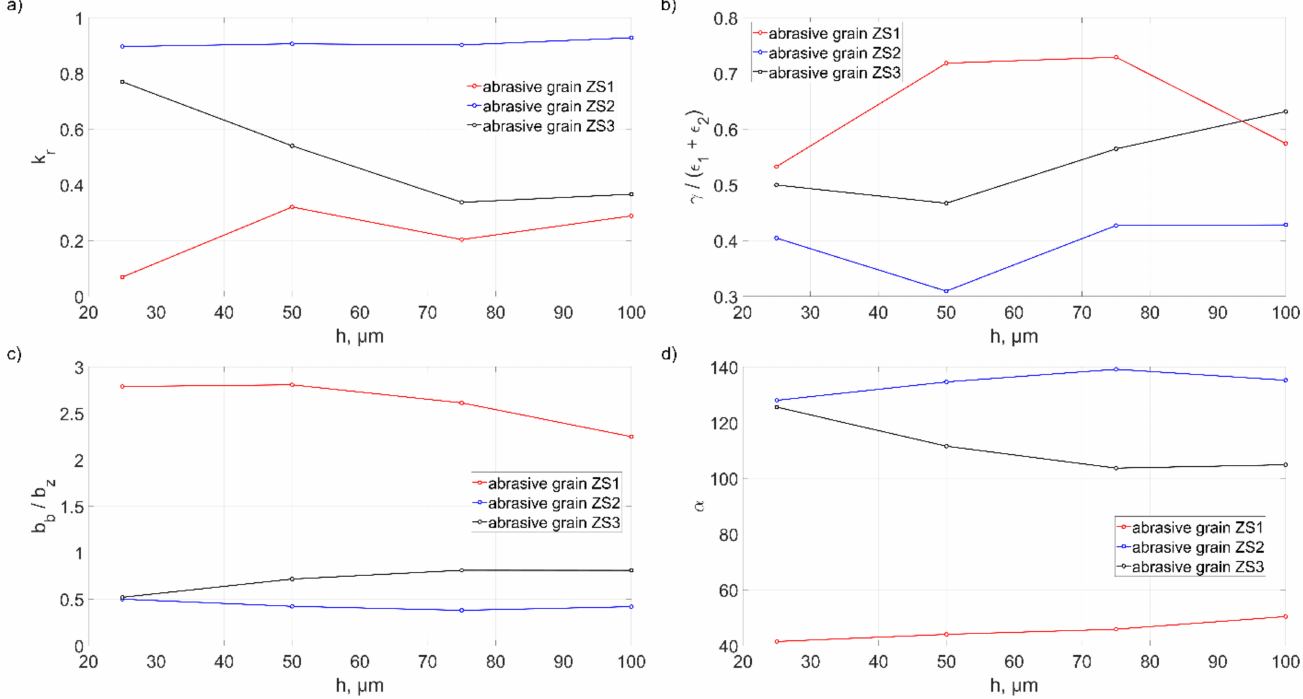
Figure 18. Influence of cutting depth h of abrasive grains with different geometry on: ( a ) the volumetric material removal coefficient k r , ( b ) the coefficient γ / ε , ( c ) the coefficient b b / b z , ( d ) the opening angle α